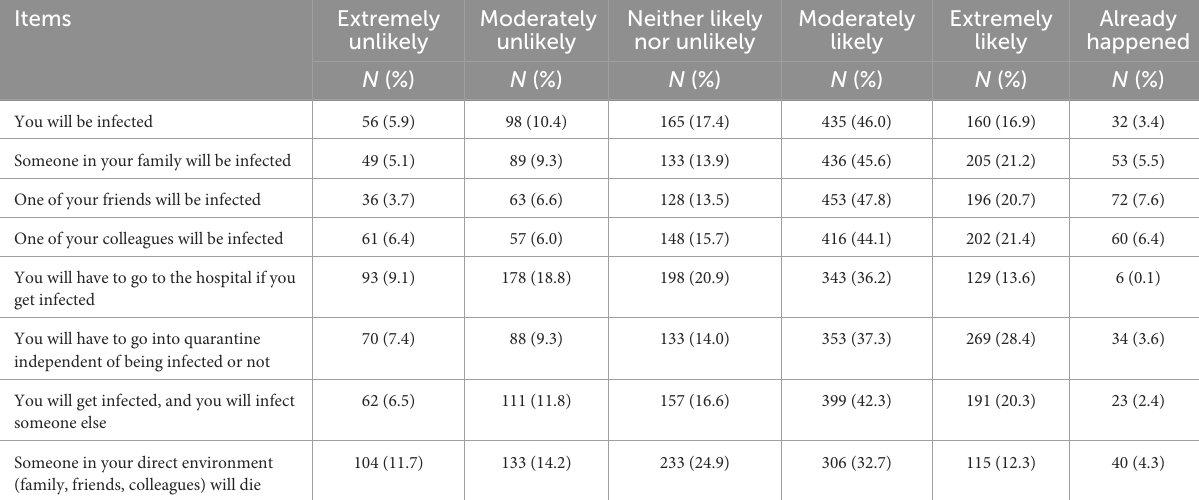
TABLE 6 Perceived risk of event likelihood related to